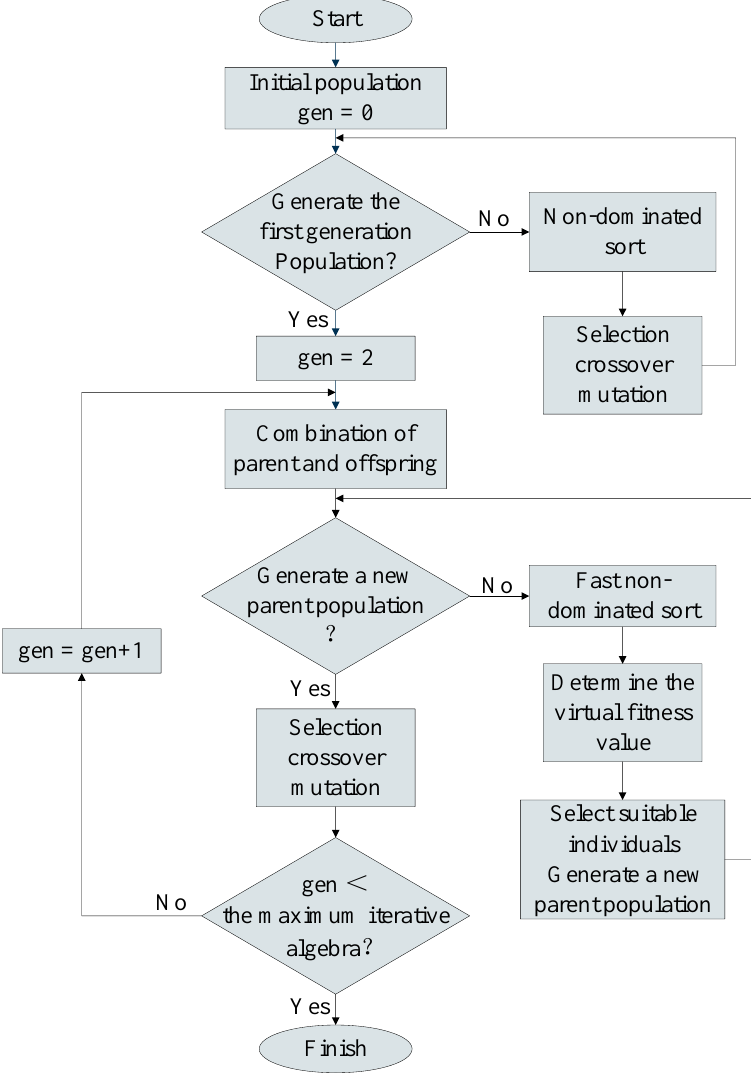
Figure 3. NSGA-II basic flow chart.